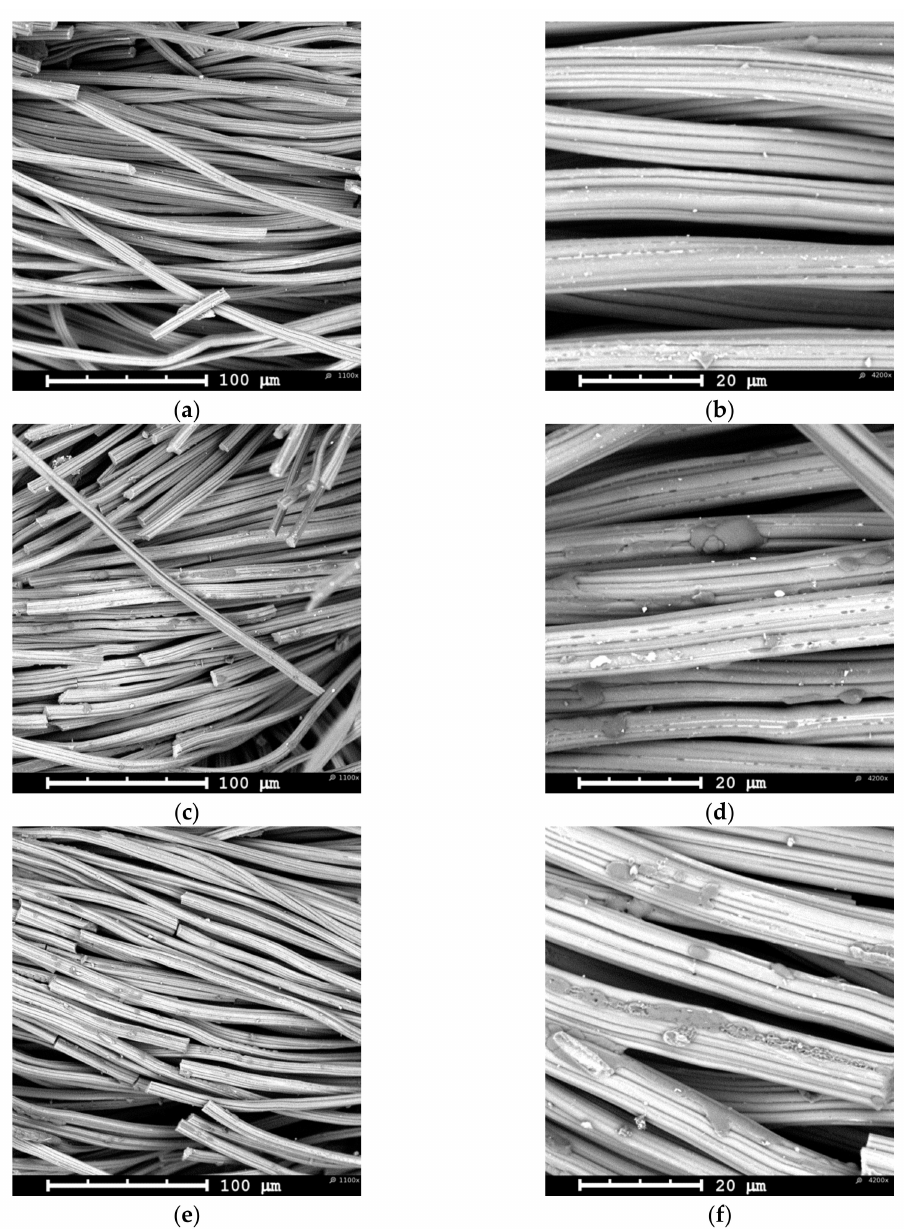
Figure 2. Low- and high-magnification Scanning Electron microscopy (SEM) micrographs of ( a ), ( b ) untreated activated carbon cloth (ACC) and PAni-ACC composites synthesized after ( c ), ( d ) 20 min and ( e ), ( f ) 40 min of